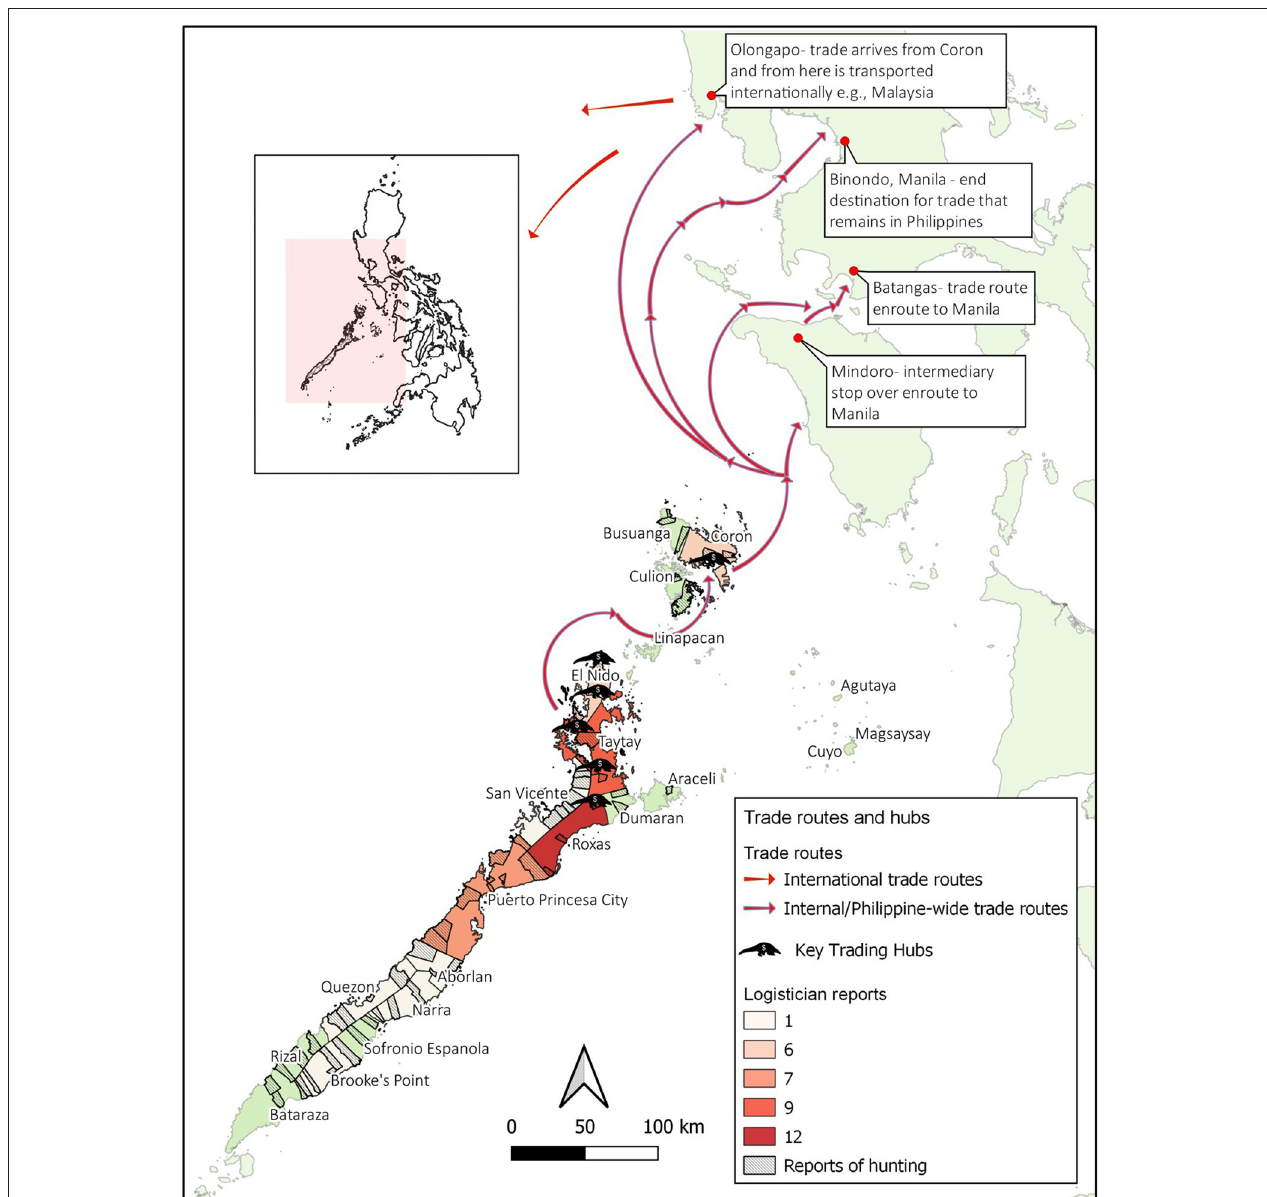
FIGURE 4 | Map of pangolin trade routes and actors. Grey shaded areas outlined in black indicate areas where hunting was reported; red shaded areas indicate the number of logistician reports per municipality; pangolin icons indicate key trade hubs; and arrows represent internal and international trade